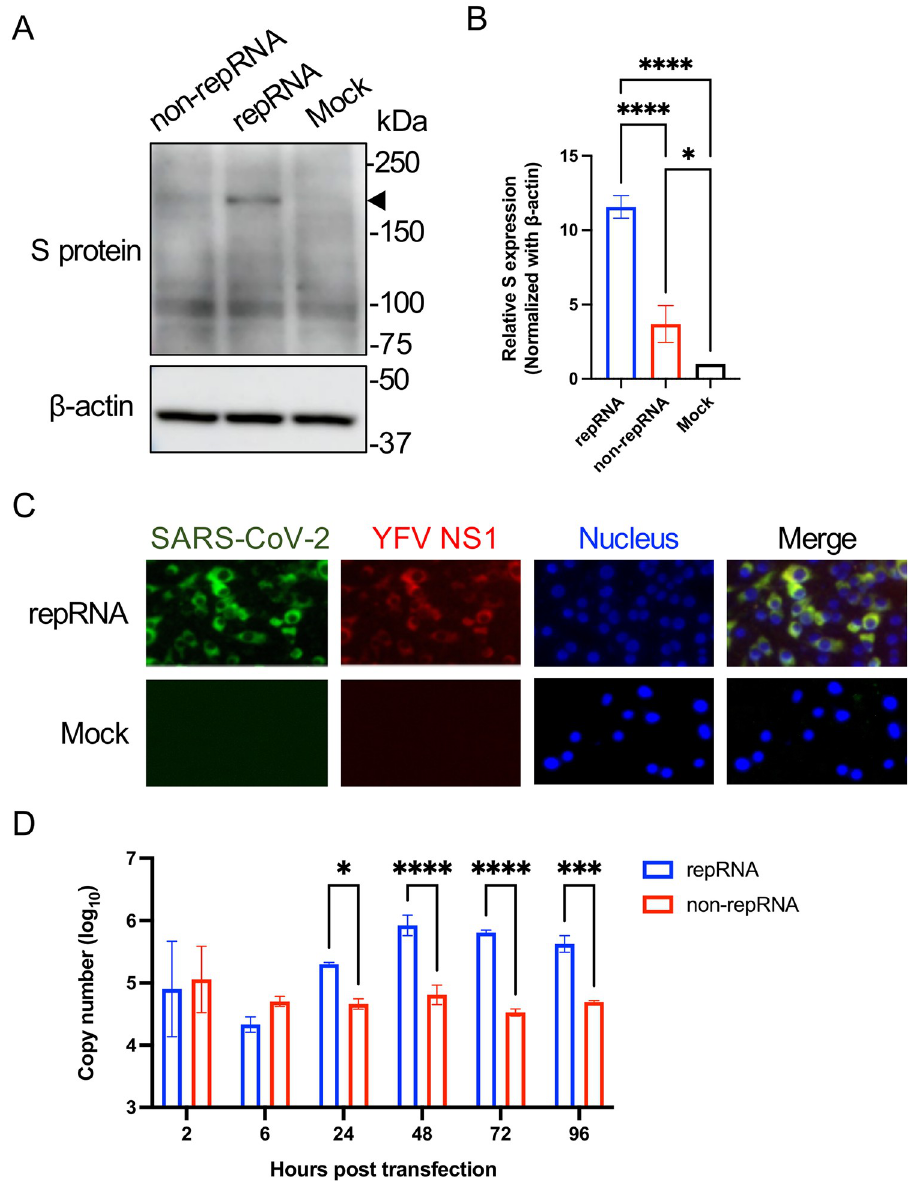
Fig 2. Characterization of repRNA and non-repRNA vaccines in vitro . (A) Confirmation of SARS-CoV-2 S protein expression via western blotting. BHK cells were electroporated with either the repRNA or non-repRNA vaccine and subjected to western blotting at 48 h post transfection. The triangle indicates the full-length S protein (approximately 180 kDa). Original unedited blot images are shown in the S1 Raw image. (B) Quantification of the S protein. The band intensity was quantified using the ImageJ software. The S protein expression level was normalized by β -actin. p-values were determined using one-way ANOVA, and p < 0.05 was considered significant ( � p < 0.05, ���� p < 0.0001). (C) The detection of S protein and YFV NS1 protein using immunofluorescence assay. BHK cells were electroporated with 10 μ g of repRNA vaccine. At 48 h post transfection, the cells were fixed with 4% paraformaldehyde, followed by permeabilization with 0.5% Triton-X. The expression of S protein was detected using anti-S mAb and goat-anti-mouse IgG conjugated with Alexa Fluor 488; YFV NS1 protein expression was detected using anti-NS1 pAb and goat-anti- rabbit IgG conjugated with Alexa Fluor 568. Cell nuclei were stained with DAPI. Untransfected BHK cells were used as a negative control. (D) Kinetics of the RNA levels. BHK cells were electroporated with repRNA or non-repRNA vaccines. RNA copy numbers were then measured using qRT-PCR. p-values were determined using two-way ANOVA, with p < 0.05 considered to be significant ( � p < 0.05, ��� p < 0.001, ���� p < 0.0001). Statistically significant values are represented in the